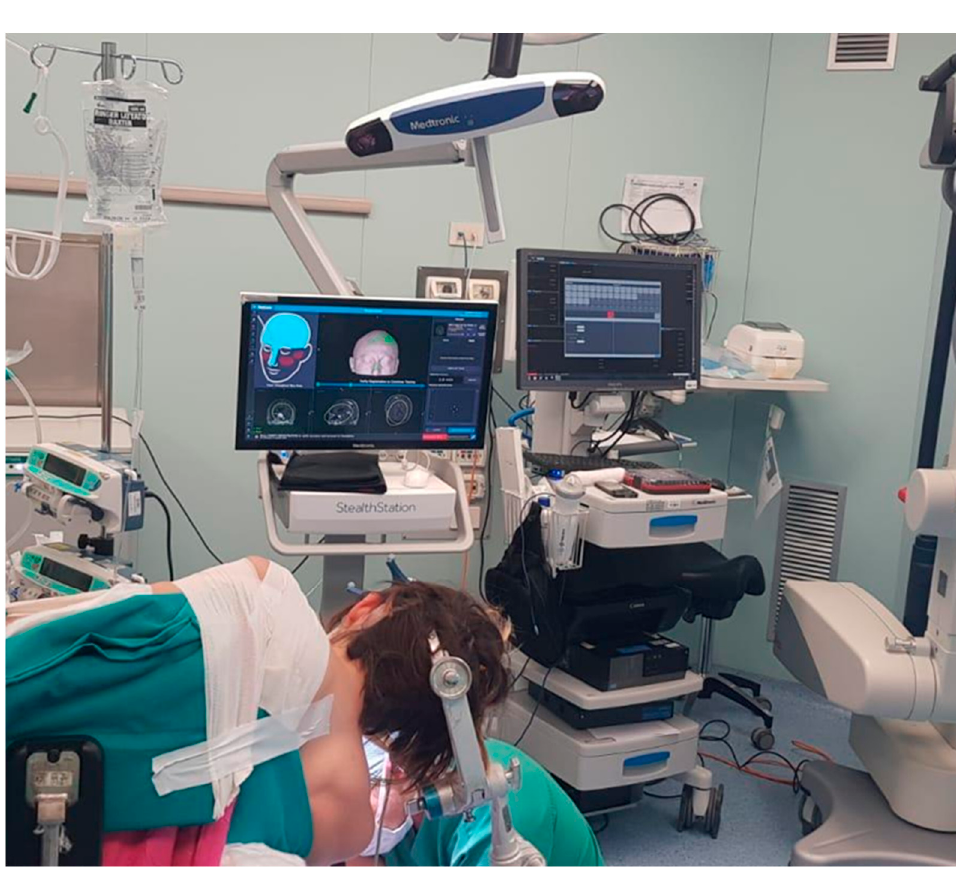
Figure 2. Park-bench position for neuronavigated assisted CPA surgery.